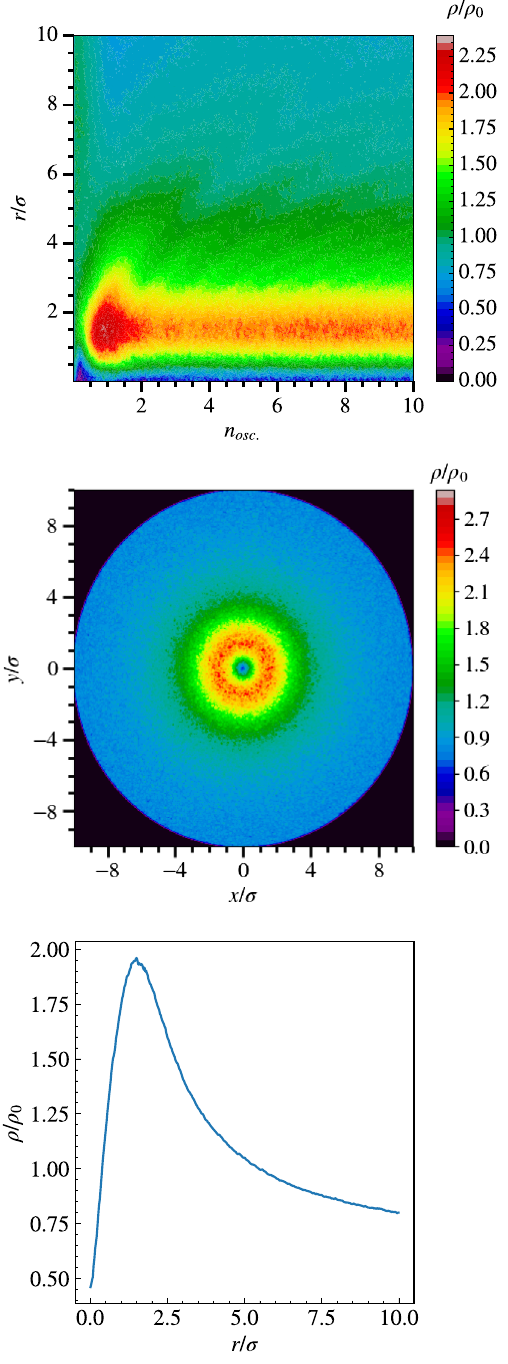
FIG. 18. Molecule density as a function of the radius and time (top), and the end time-averaged local molecule density versus radius (bottom). The center panel shows the x - y structure of the molecule density at the point of maximum density. The molecule density is normalized with respect to the initial (or space- averaged) molecule density. In this simulation, the molecules are at a temperature T=T (cid:3) p ¼ 0 . 1 , and the particles initially distributed throughout the transverse x - y space. According to the top panel (color scale), the peak density is ∼ 2 . 4 times the initial uniform density.